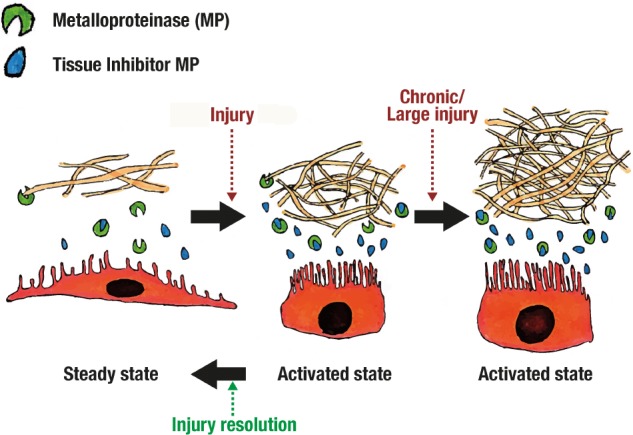
Adherence formation.